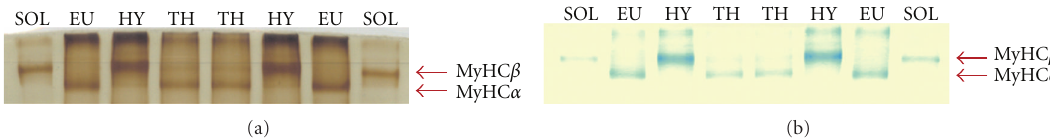
Figure 1: SDS-PAGE separation of cardiac MyHC isoforms from left ventricles of adult euthyroid (EU), hypothyroid (HY), and hyperthyroid (TH) Lewis rats. Control: soleus muscle (SOL) from the hypothyroid rat containing the MyHC1 isoform identical with cardiac MyHC β . The gel was silver stained (a) or stained by CBB+BBR (b) before MALDI TOF/TOF analysis.